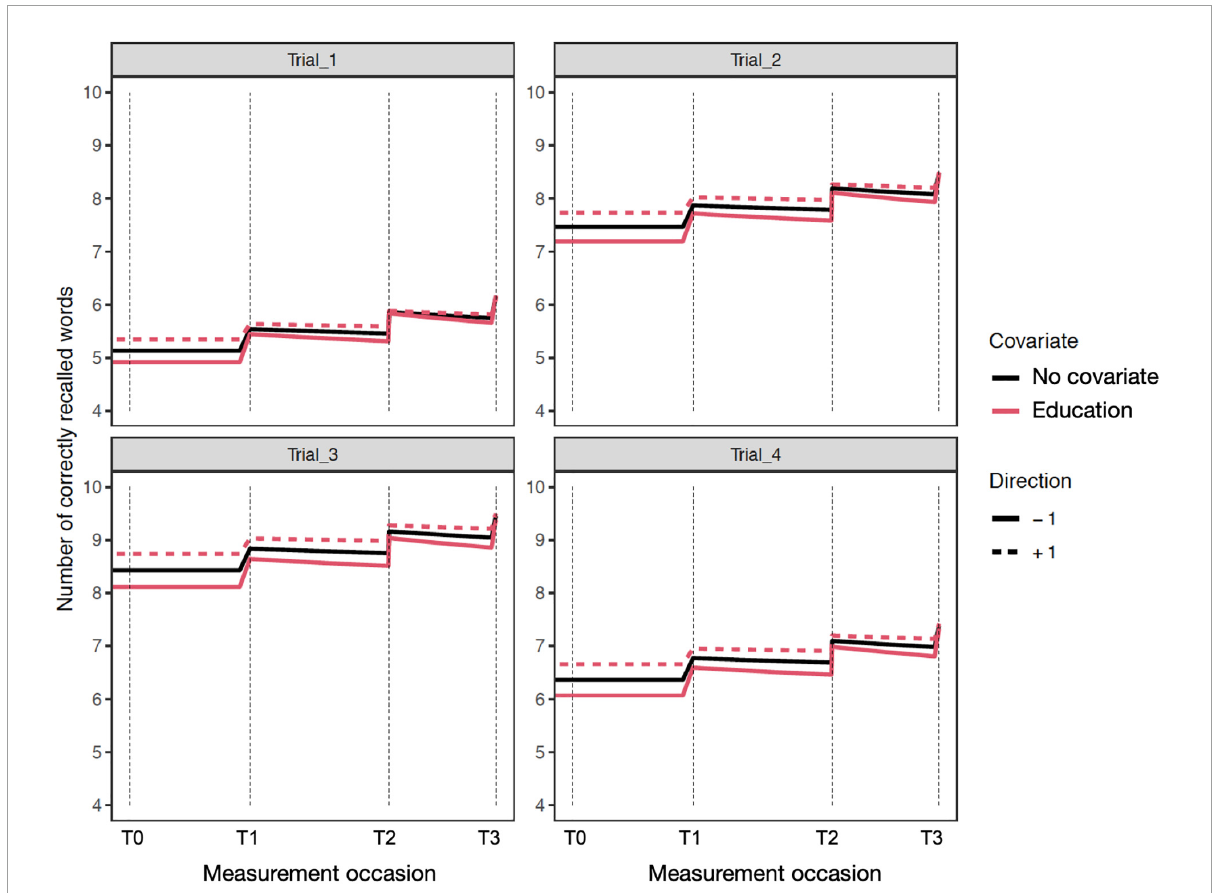
FIGURE1 Expectation plots for change in recall performance (black line) across four measurement occasions (e.g., T0: baseline, T1: 1 year). The solid and dashed red lines depict effect modification by education; higher (dashed) and lower (solid) levels of education predict different levels and patterns of change. The complete guide to interpreting expectation plots can be found in Section “A Guide to Interpreting Model Results and